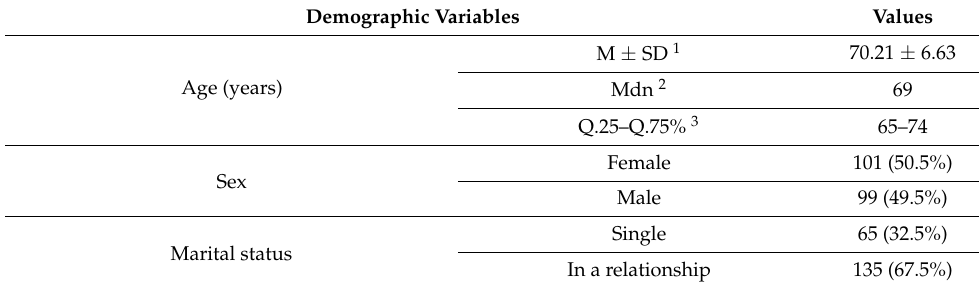
Table 1. Study group characteristics (n =